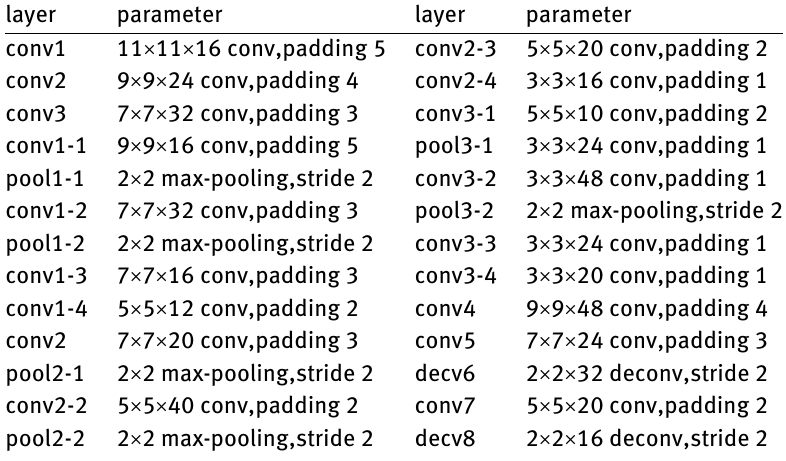
Table 1: The detail of parameters